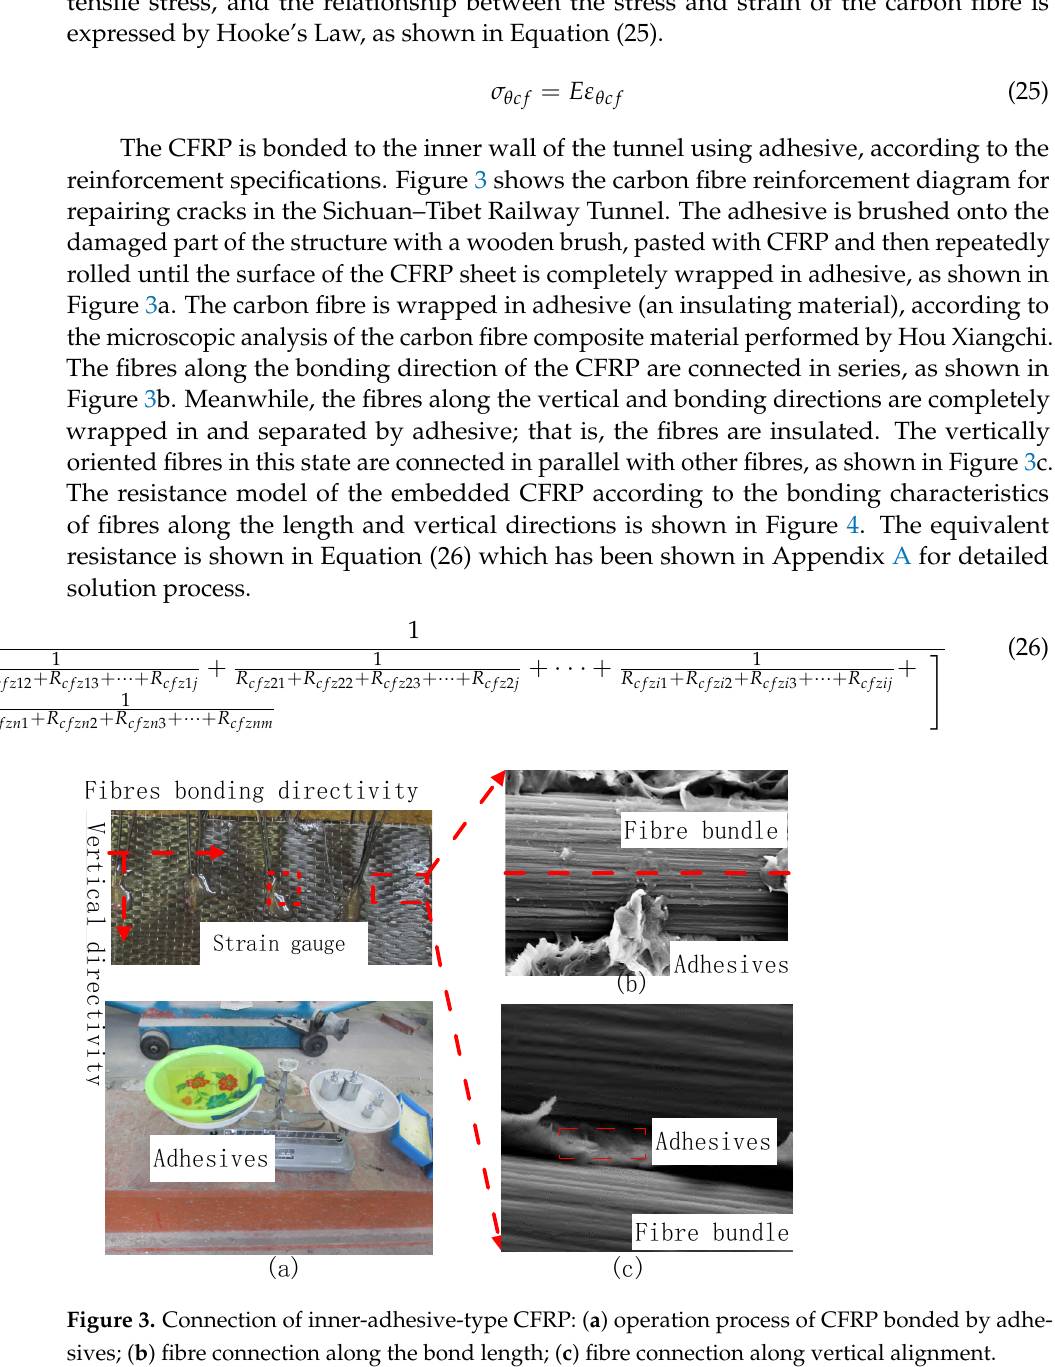
Figure 4. Resistance relationship of the embedded CFRP. The piezoresistive model of the embedded CFRP can be obtained by combining Equations (23) and (26), as shown in Equation (27), (